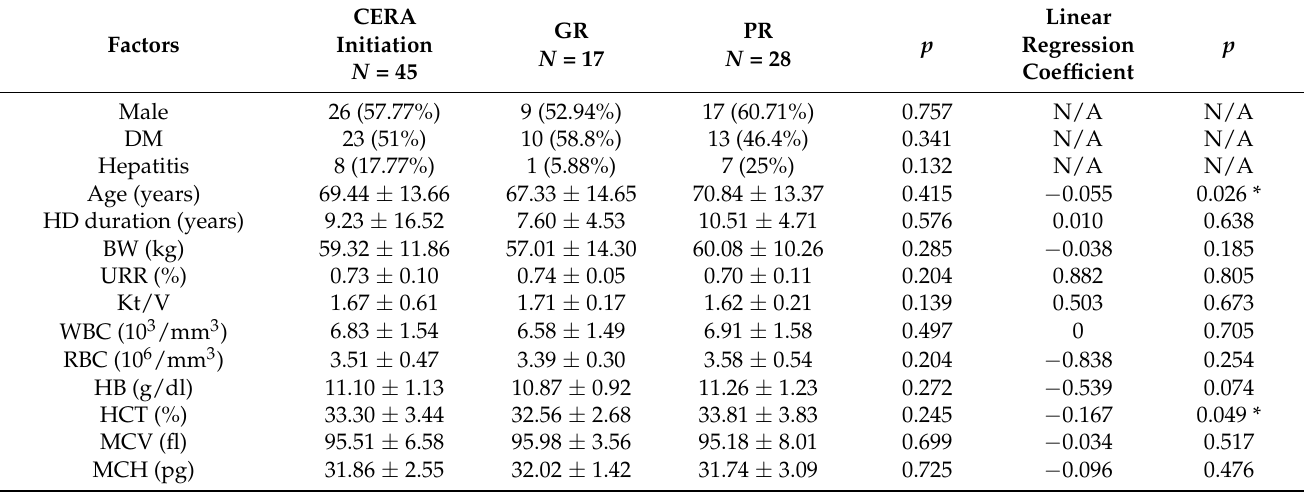
Table 1. Baseline demographic and biochemical factors associated with erythropoietic response.